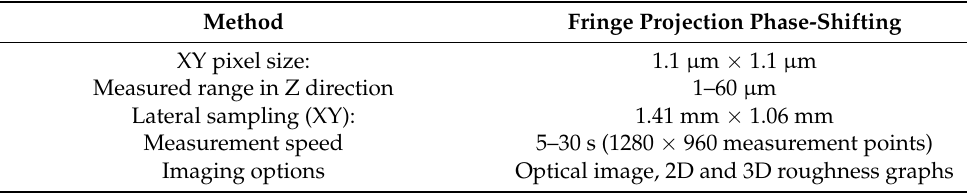
Table 2. Technical specifications 3D Topography module with OneAttension Theta.